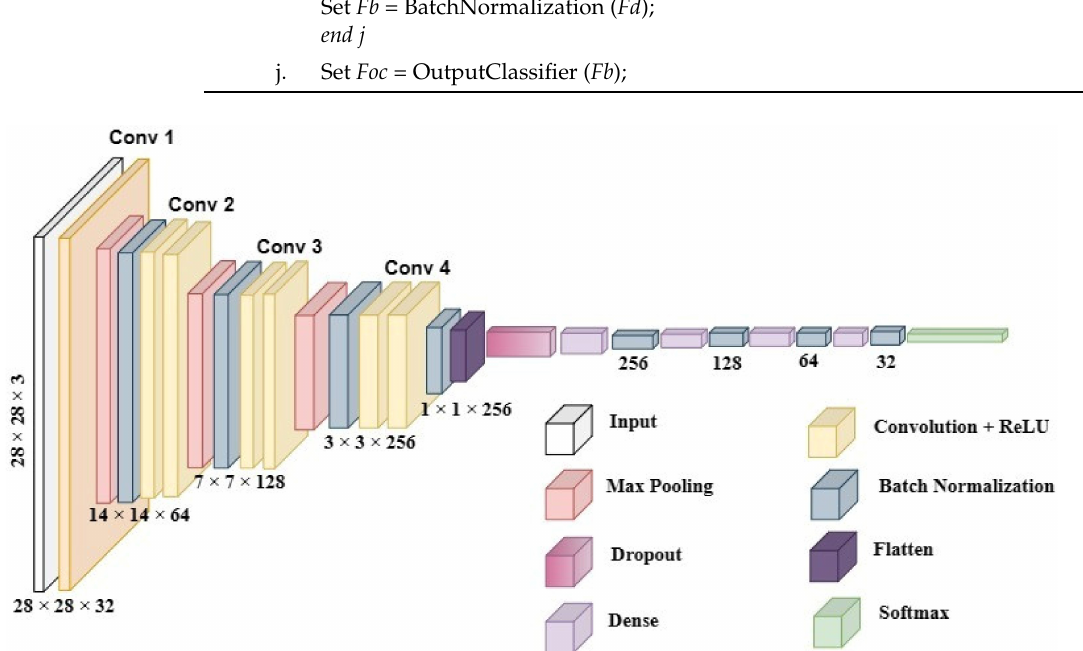
Figure 3. Layered architecture of proposed CNN